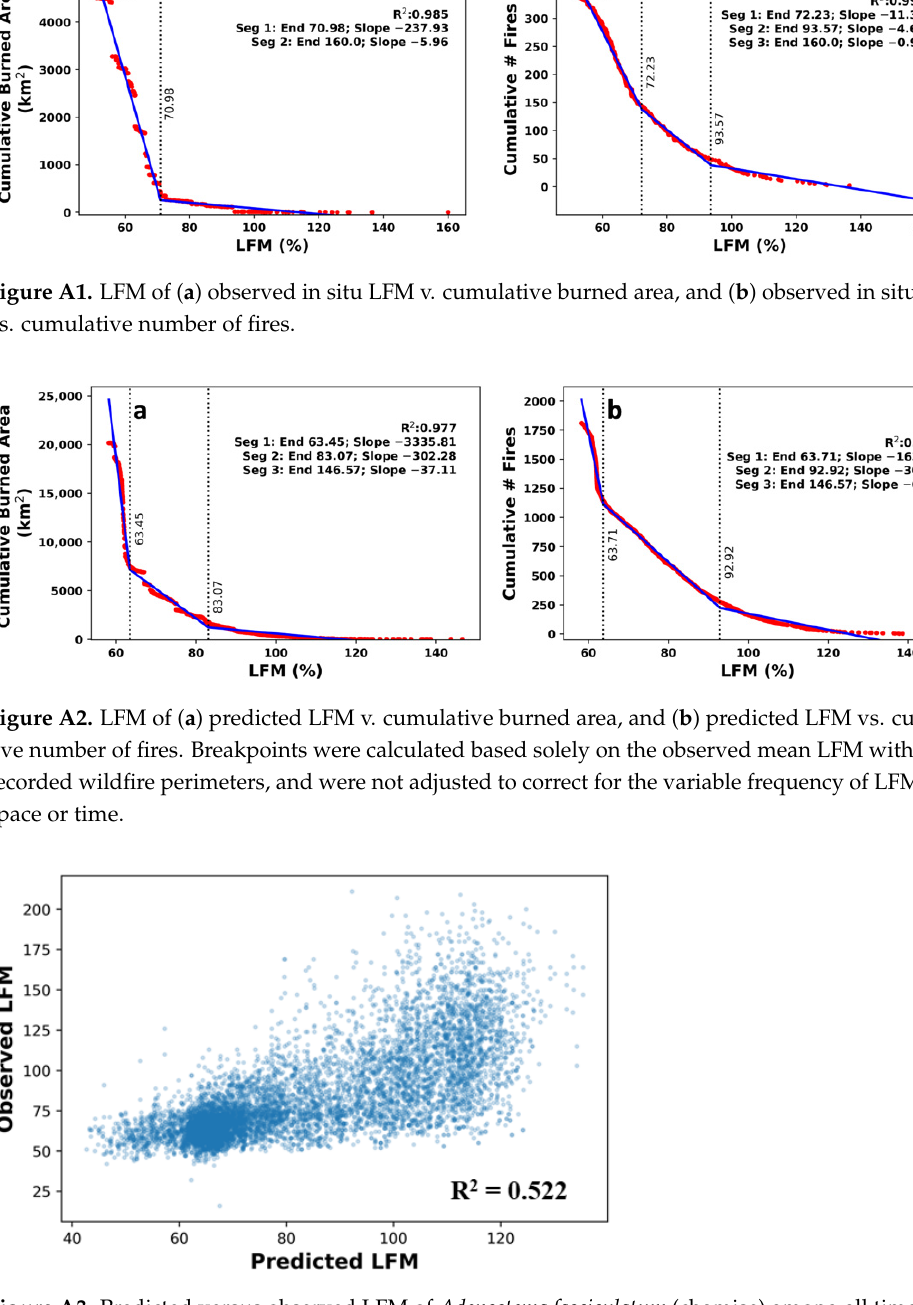
Figure A3. Predicted versus observed LFM of Adenostema fasciculatum (chamise) among all times and locations observed in this study, using a model calculated based on 6 month cumulative CWD, and 1 month CWD and AET (with lags of 2 months).